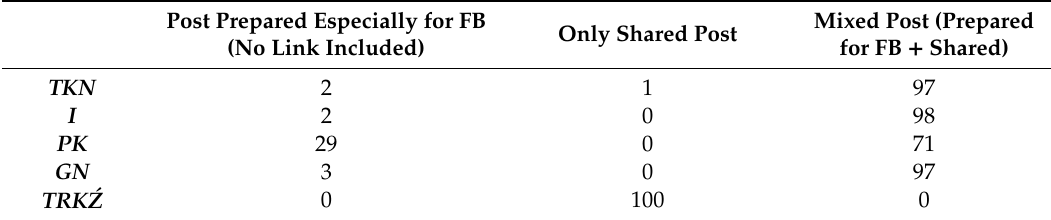
Table 8. Post preparation